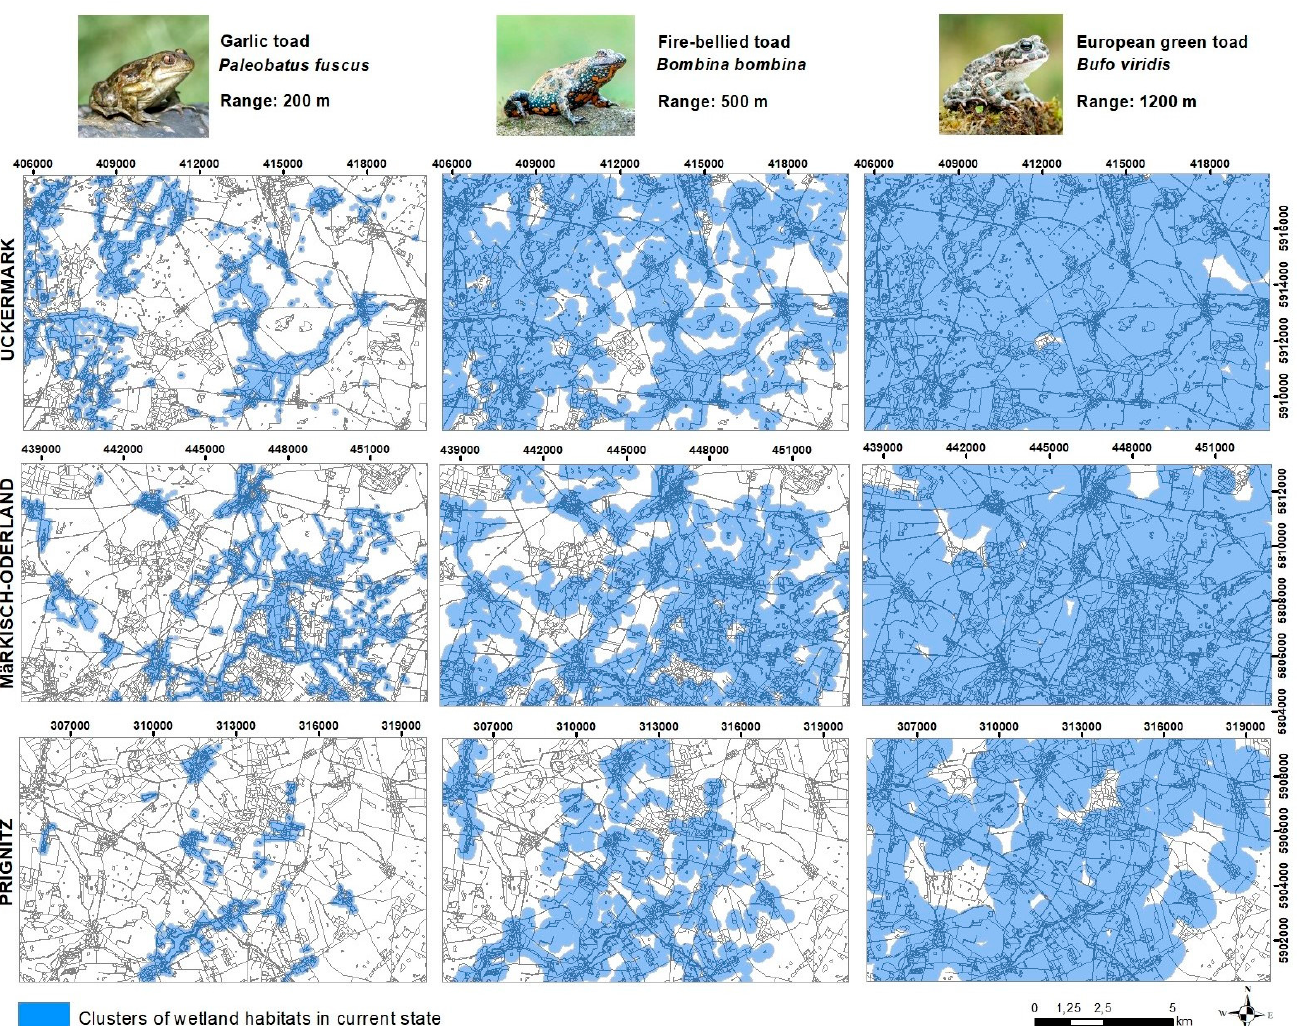
Figure 4. Habitat clusters for garlic toad (range of 200 m), fire-bellied toad (500 m), and European green toad (1200 m) at the current state in Uckermark, Märkisch-Oderland, and Prignitz. The clusters represent areas within which genetic exchange is considered possible for the species. The lower the number of clusters, the higher the degree of functional connectivity.